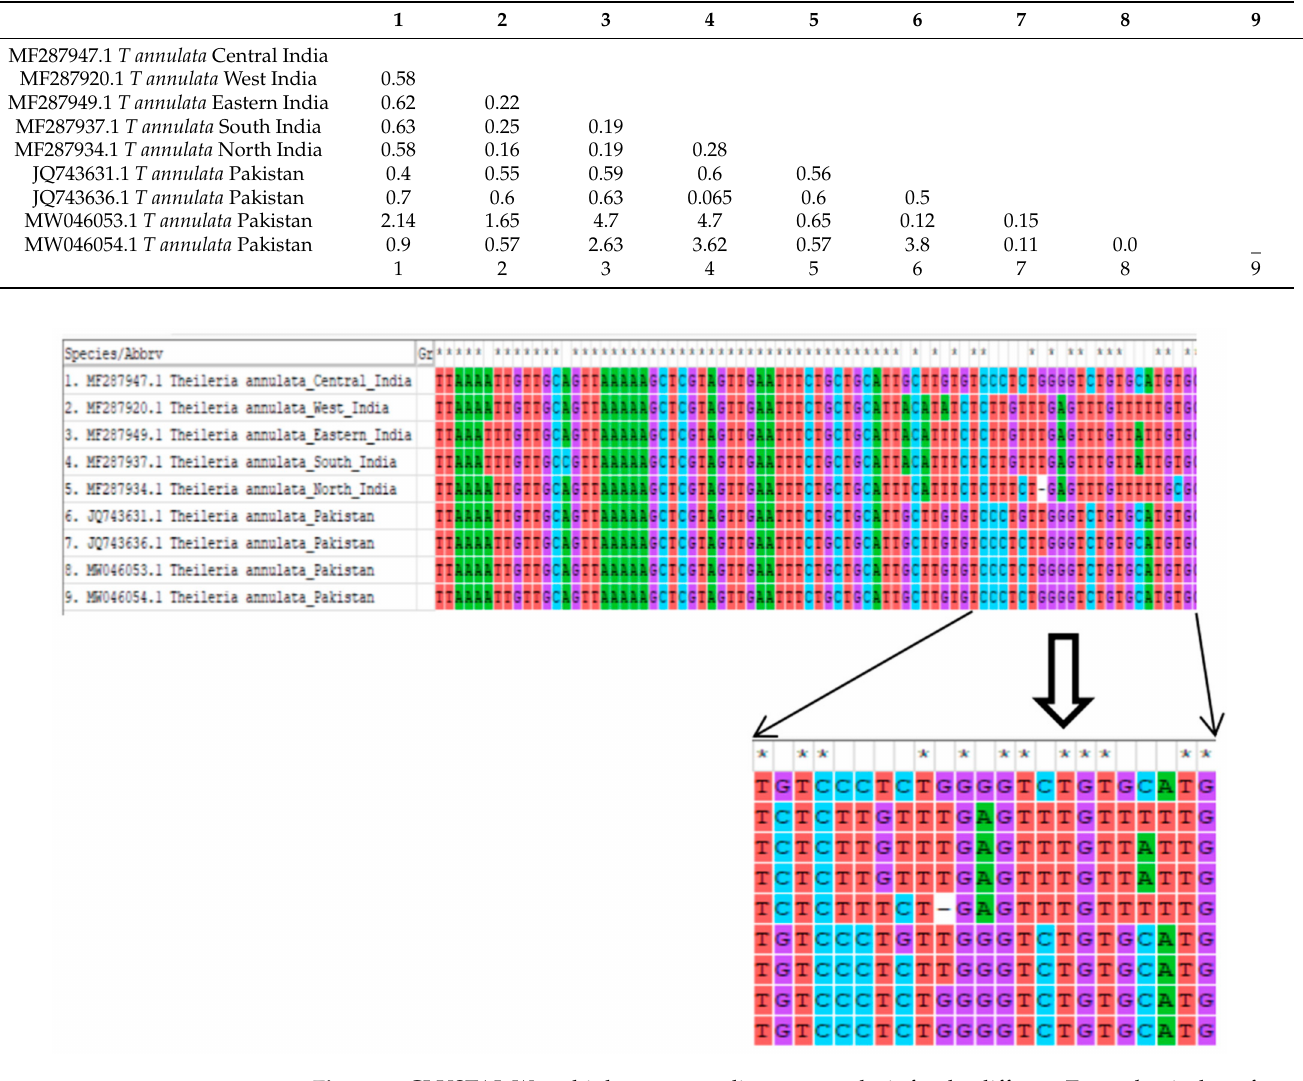
Figure 7. CLUSTAL W multiple sequence alignment analysis for the different T. annulata isolates from India and Pakistan. The box below showing the changes in nucleotide sequences between T. annulata isolates from Pakistan and India. * means nucleotide